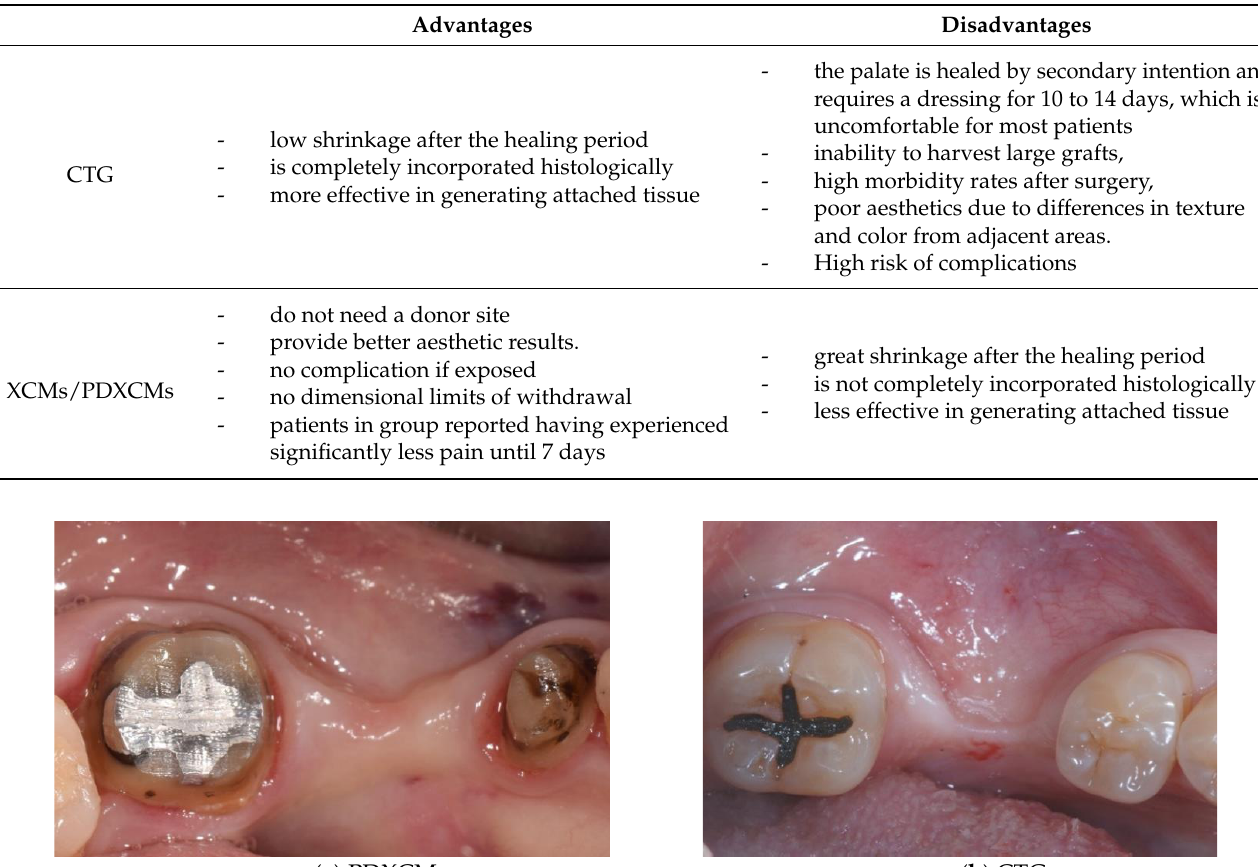
Table 6. Advantages/disadvantages of XCM, PDXCM, vs. CTG.